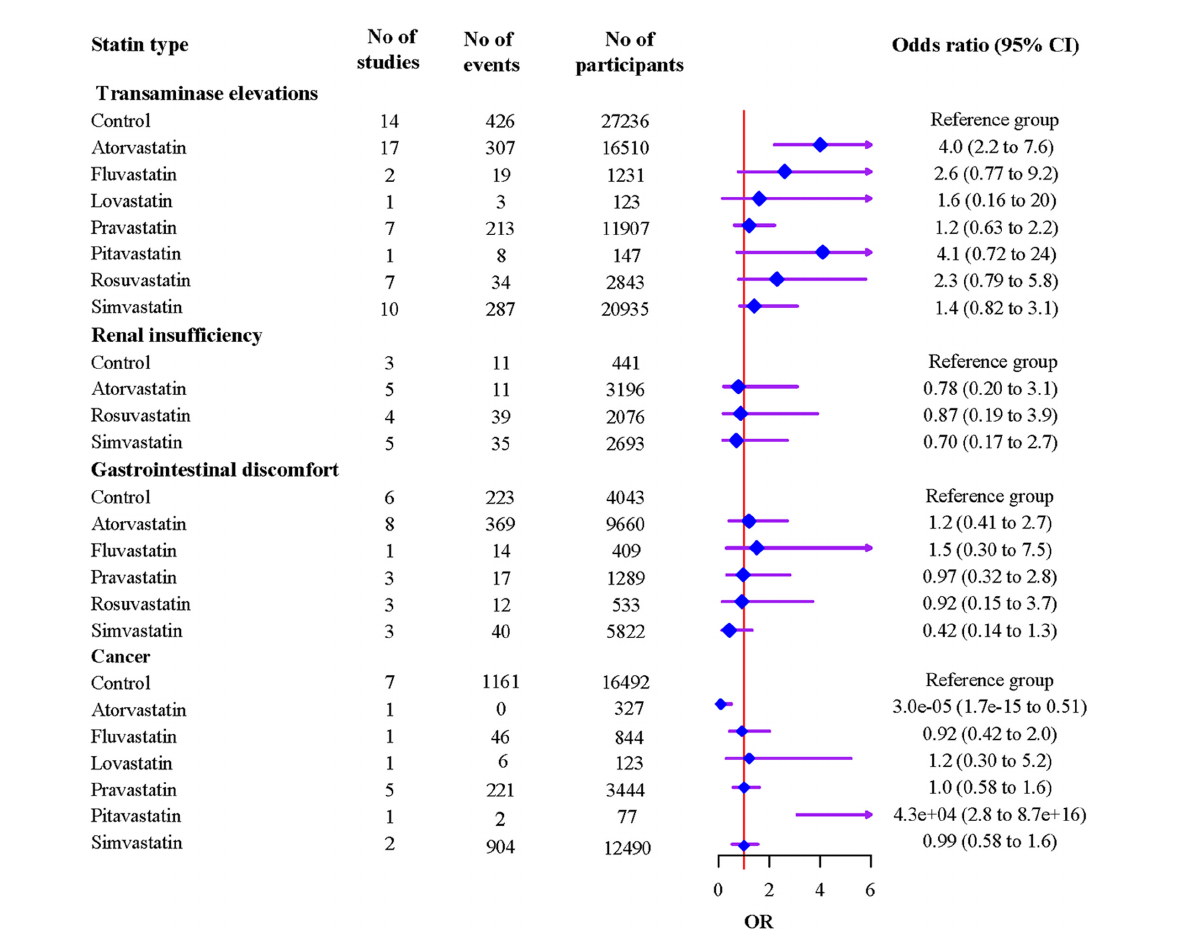
lovastatin (56.2%), rosuvastatin (43.0%), fluvastatin